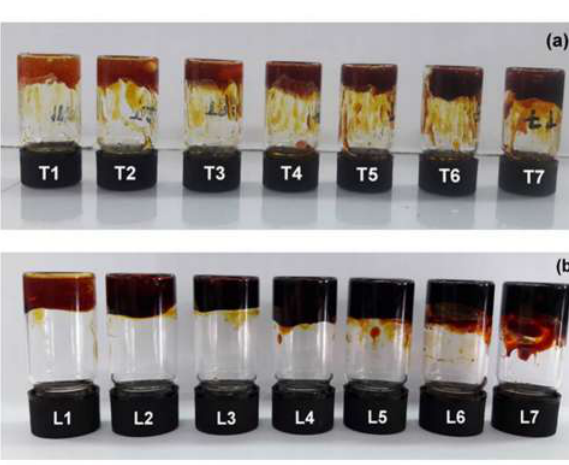
Figure 1. Photographs of PhSt-HEC-DMF gel electrolytes with ( a ) TPAI and ( b ) LiI.